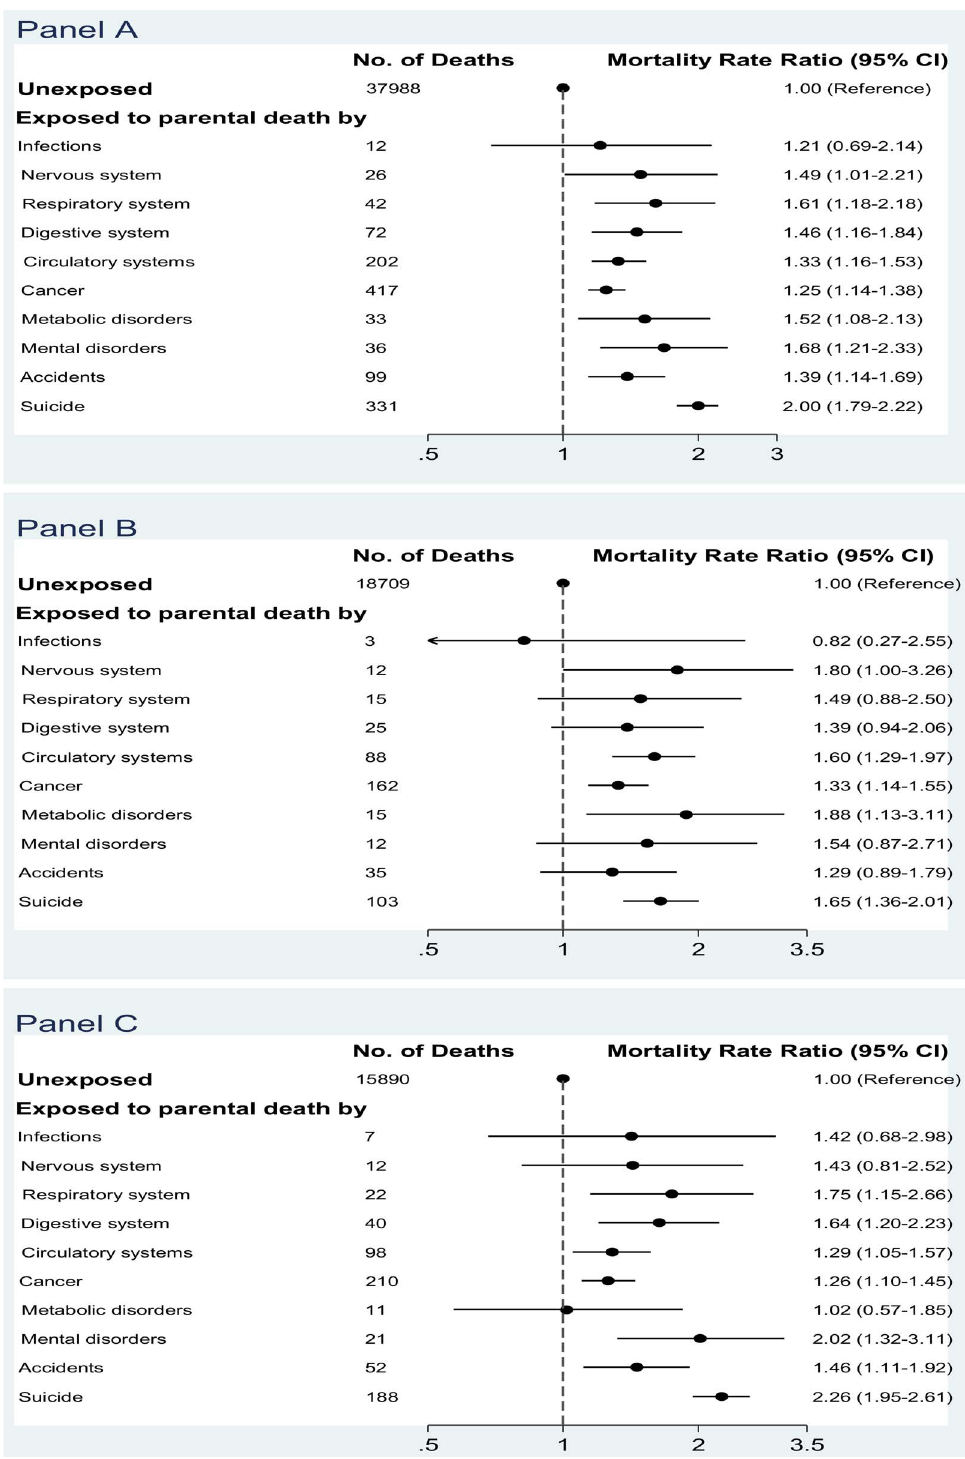
Figure 1. Mortality rate ratios after parental death in childhood, according to specific cause of parental death. (A) All-cause mortality in children; (B) mortality from natural death in children; (C) mortality from unnatural death in children (MRRs were adjusted for country, age, sex, calendar year period, birth outcomes [birth weight, the Apgar score at 5 minutes, preterm birth], and maternal variables [age, parity, education, and social status]). doi:10.1371/journal.pmed.1001679.g001 three sub-categories, 1.42 (1.22–1.65) for ‘‘not in labor market,’’ 1.50 (1.31–1.75) for ‘‘unskilled workers,’’ and 1.36 (1.16–1.61) for except those with top level status, we observed similar magnitudes ‘‘skilled workers/white collars,’’ respectively (Table 4). of the association between parental death and mortality in other